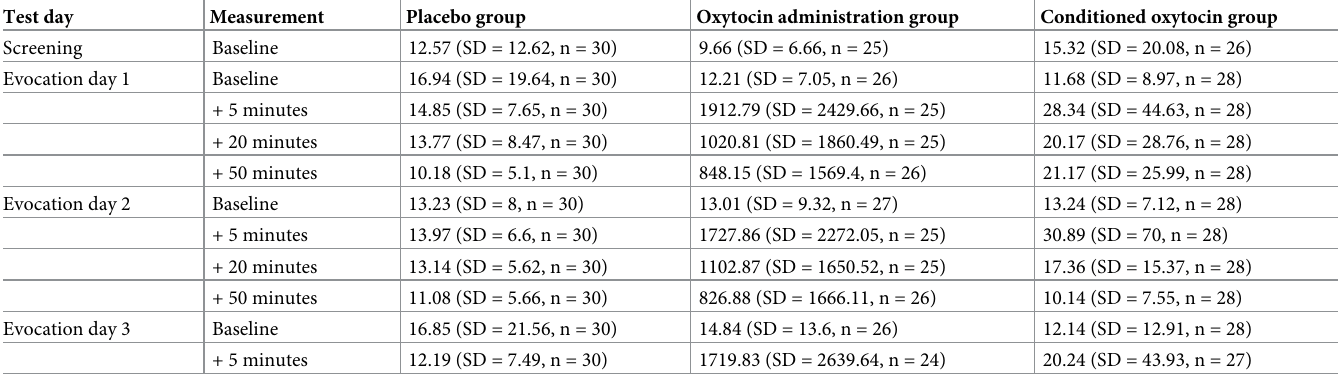
Table 1. Mean salivary oxytocin levels (pg/ml) and standard deviations (SD) across the groups and measurement